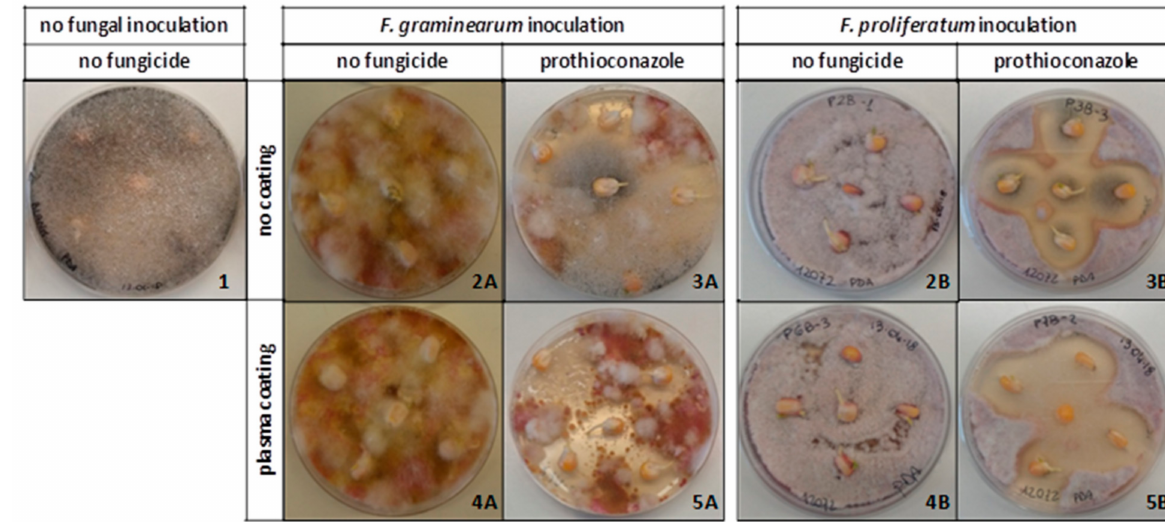
Figure 1. Maize seed contamination evaluated after 3 days, on different Theses, inoculated and not inoculated with Fusarium , coated and not by means of plasma deposition, treated and not with prothioconazole. The thesis number is shown at the bottom right of each